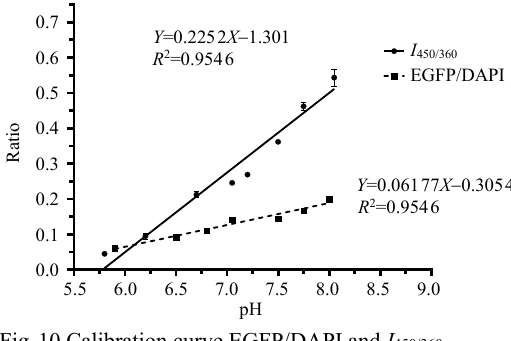
Fig. 10 Calibration curve EGFP/DAPI and I 450/360 .